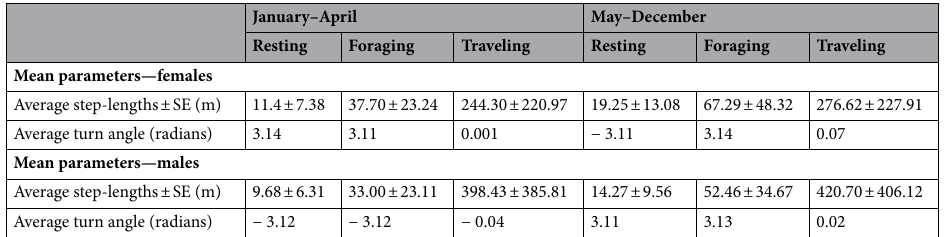
Table 4. Average step-lengths (± SE) and turning angles for each designated behavioral state by sex in the 3-state HMMs with the additive effect of hour of day of wild pigs ( Sus scrofa ) on the Savannah River Site in South Carolina based on GPS locations from two distinct seasons based on forage availability, low-forage availability (January–April) and high-forage availability (May–December).